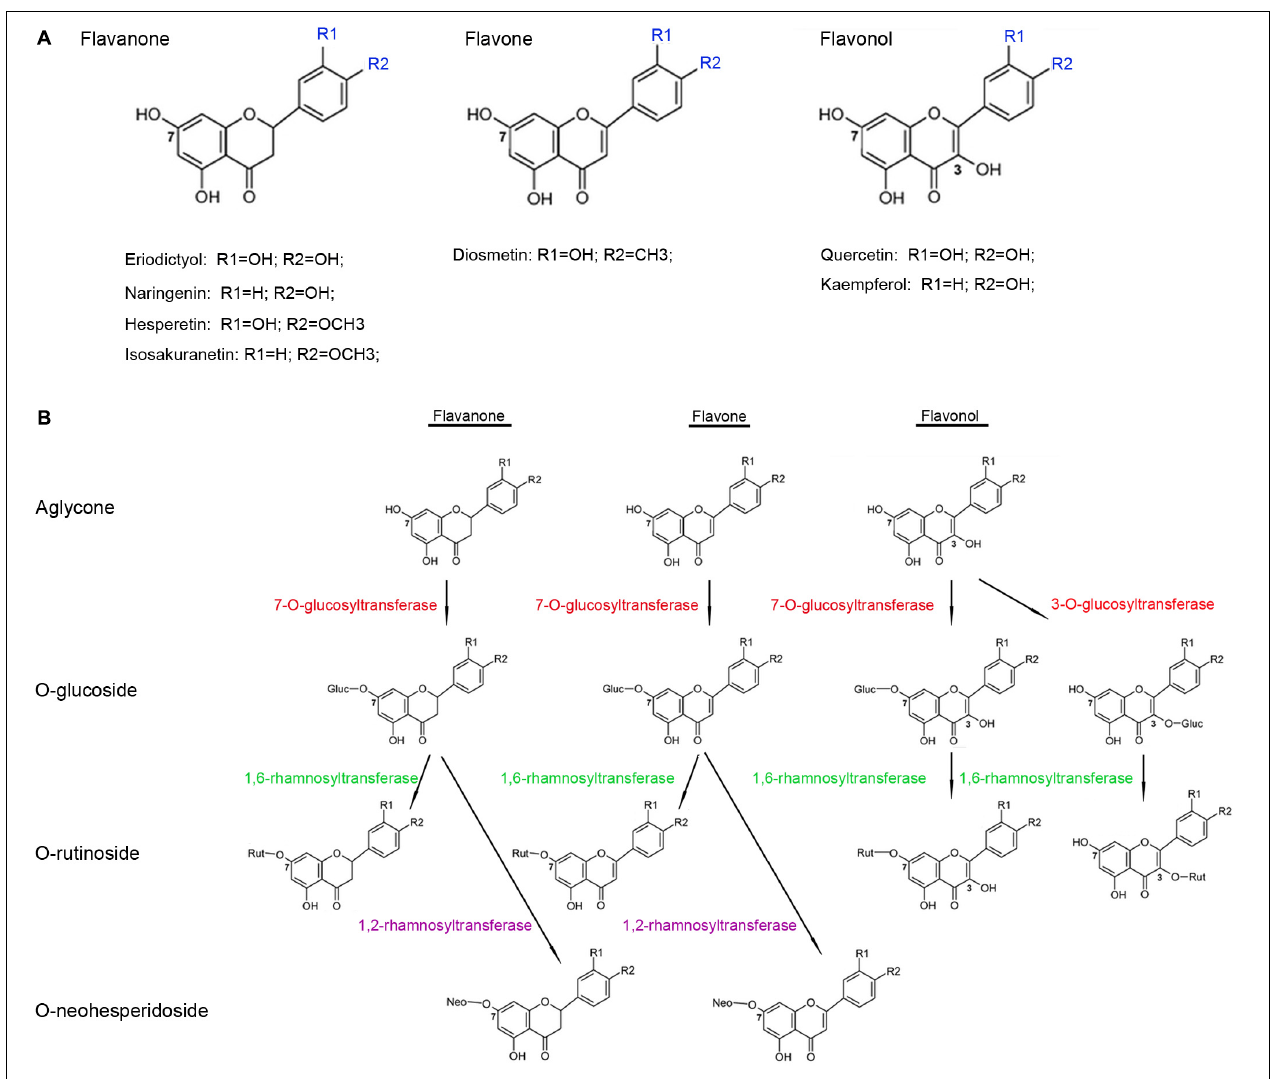
FIGURE 1 | Structure (A) and glycosylation process (B) of flavonoid aglycones in Citrus